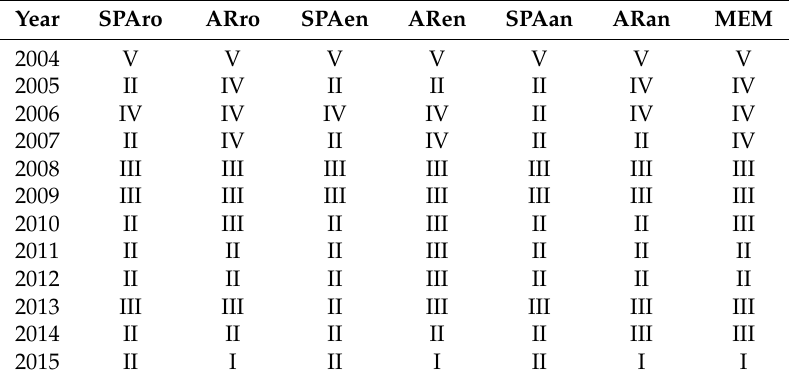
Table 10. The evaluation results based on seven methods from 2004 to 2015.